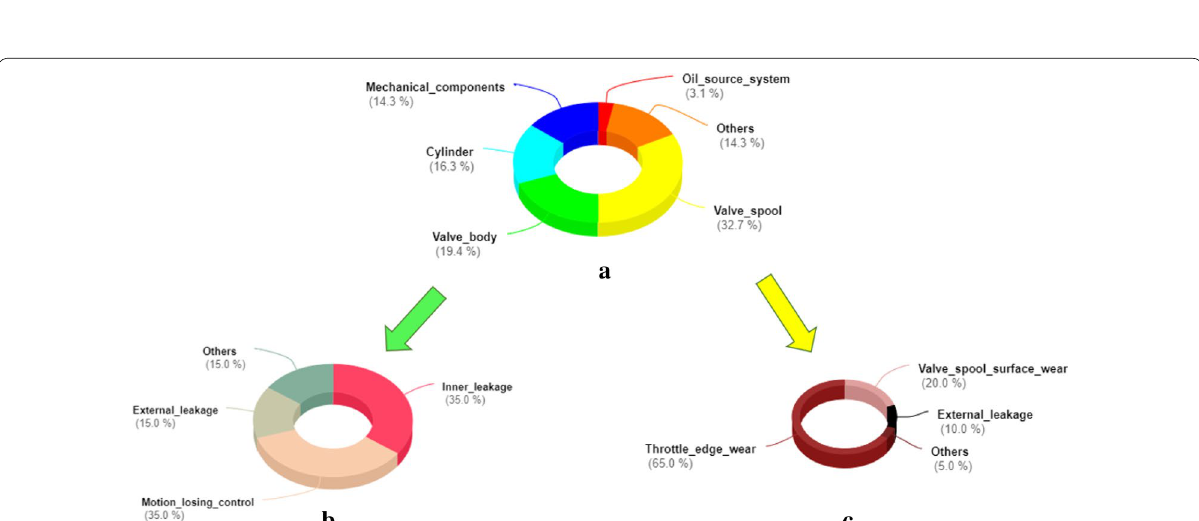
Figure 17 ( a ) The proportion of each element failure; ( b ) The proportion of the valve body faults; ( c ) The proportion of the valve spool